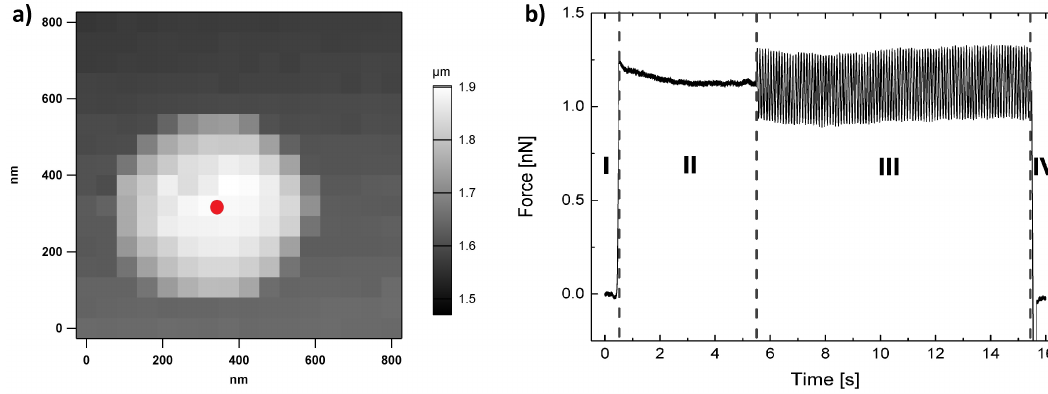
Figure 1. ( a ) Height profile from force map on microgel particle. The red dot indicates the location of the tip, where dynamic force measurements are performed; ( b ) Example force against time plot during a dynamic force measurement. Taken from